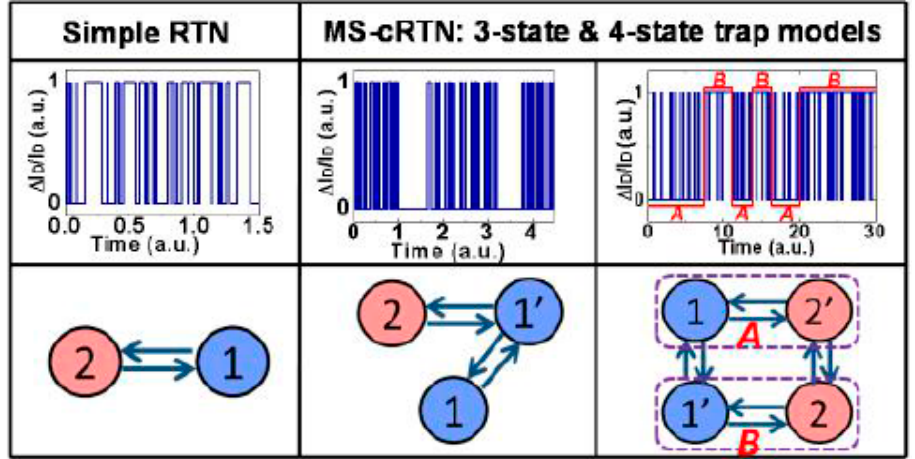
Figure 29. Illustration of the complex RTN induced by a single trap with an additional one or two metastable states, named as MS-cRTN [181].